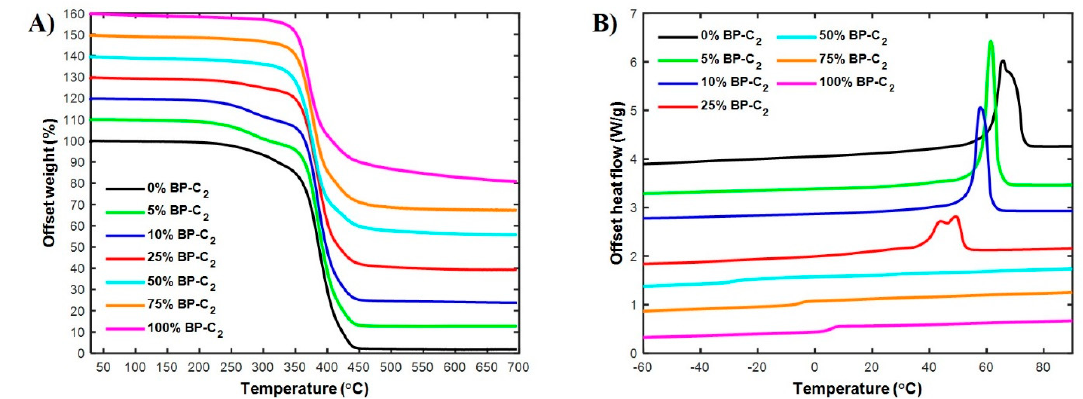
Figure 3. ( A ) Offset of TGA traces and ( B ) offset DSC traces of the second heating run for the different Figure 3. ( A ) O ff set of TGA traces and ( B ) o ff set DSC traces of the second heating run for the di ff erent polymers synthesized in this study. polymers synthesized in this study.